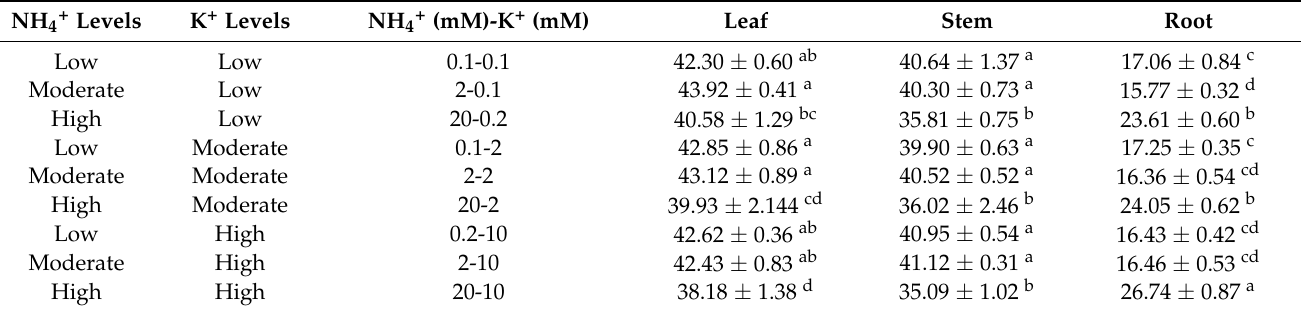
Table 5. Proportion of soluble sugar in leaves, stems, and roots (%) under different NH 4+ /and K + concentrations.